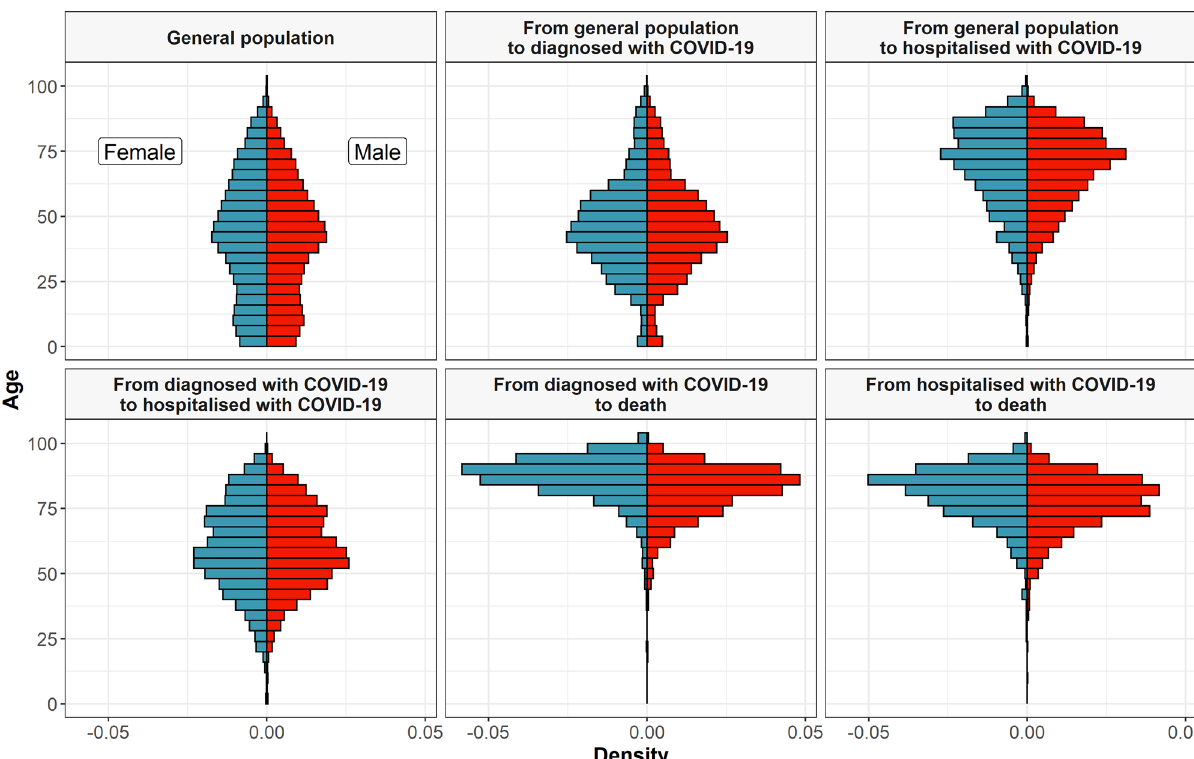
Fig. 2 Histogram of age, by sex, for the study population and by transition in the multistate model. The ages, split by sex, of the study population as a whole (general population) and of those individuals making transition from general population to diagnosed with COVID-19 and hospitalised with COVID- 19, from diagnosed with COVID-19 to hospitalised with COVID-19 and death, and from hospitalised with COVID-19 to